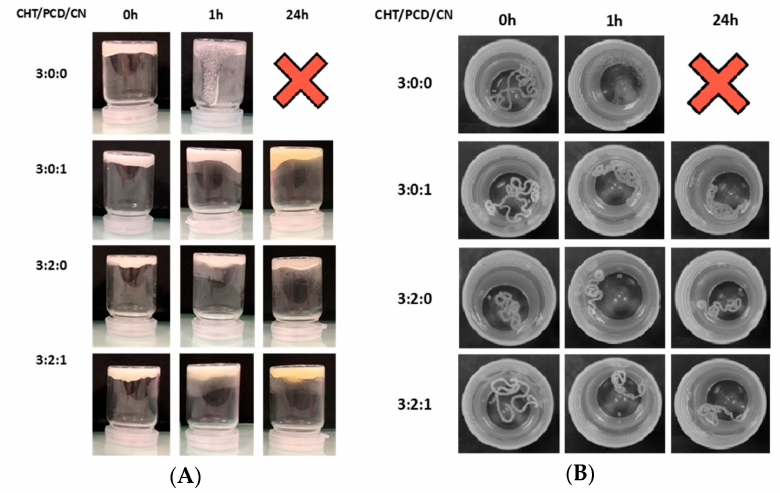
Figure 3. Gel stability tests of controls and CHT/PCD/CN hydrogels immediately after injection (0 h), after 1 h, and after 24 h. ( A ) vial turnover test at 37 ◦ C. ( B ) structural stability of gel cords injected in PBS (pH 7.4) at 37 ◦